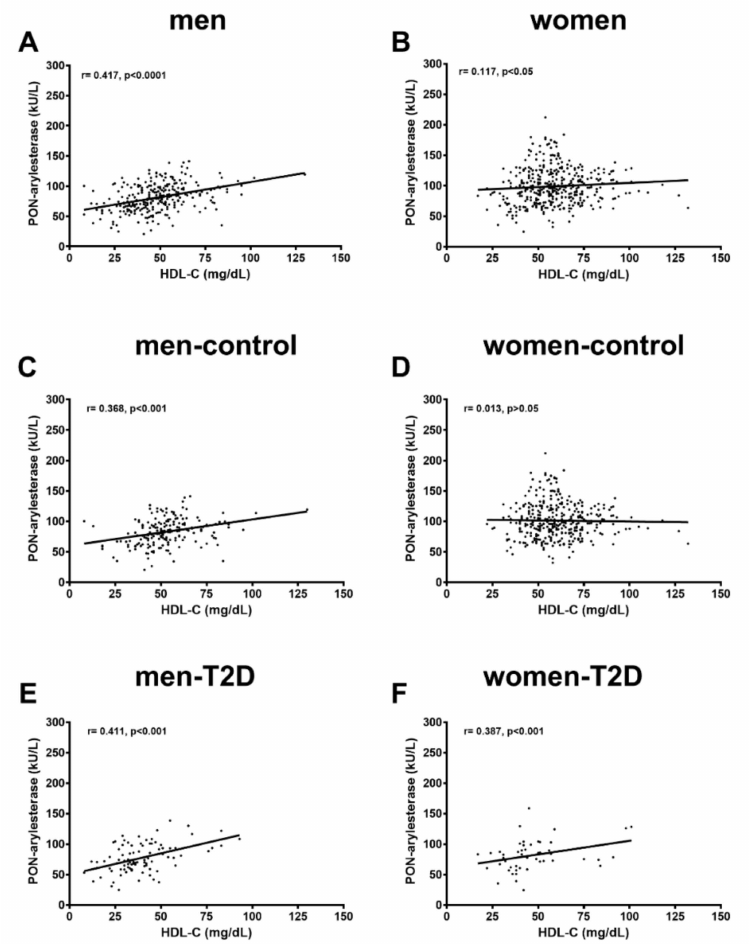
Figure 3. Correlations between PON-arylesterase activity and HDL-C levels in men ( A ) and women ( B ) and separated according to diagnosis in control men ( C ), men with T2D ( E ), control women ( D ) and women with T2D ( F ). As displayed, the correlation we found was mainly driven by men in both control and diabetes